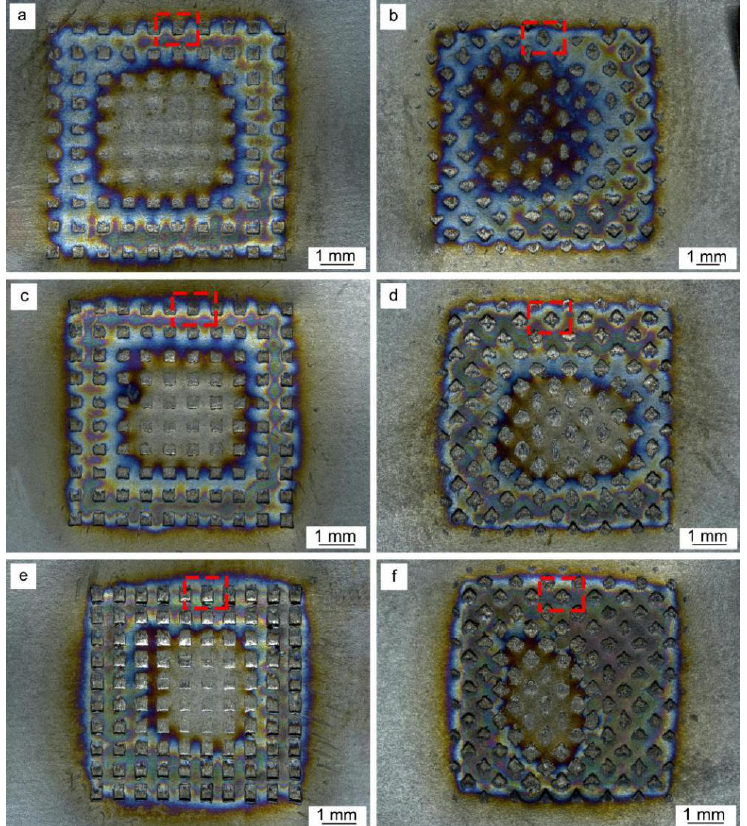
Figure 2. Surface morphology of different samples obtained with different welding energies: ( a ) sonotrode tip and ( b ) anvil sides of 500 J; ( c ) sonotrode tip and ( d ) anvil sides of 700 J; ( e ) sonotrode tip and ( f ) anvil sides of 1000 J. The red squares indicate the regions analyzed to determine the surface indentation depth depicted in Figure 3.